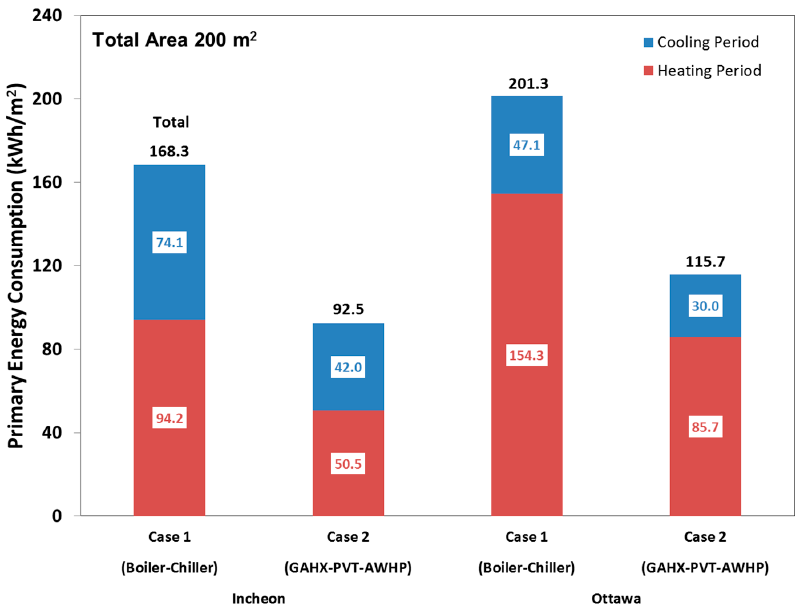
Figure 6. Annual primary energy consumption intensity.